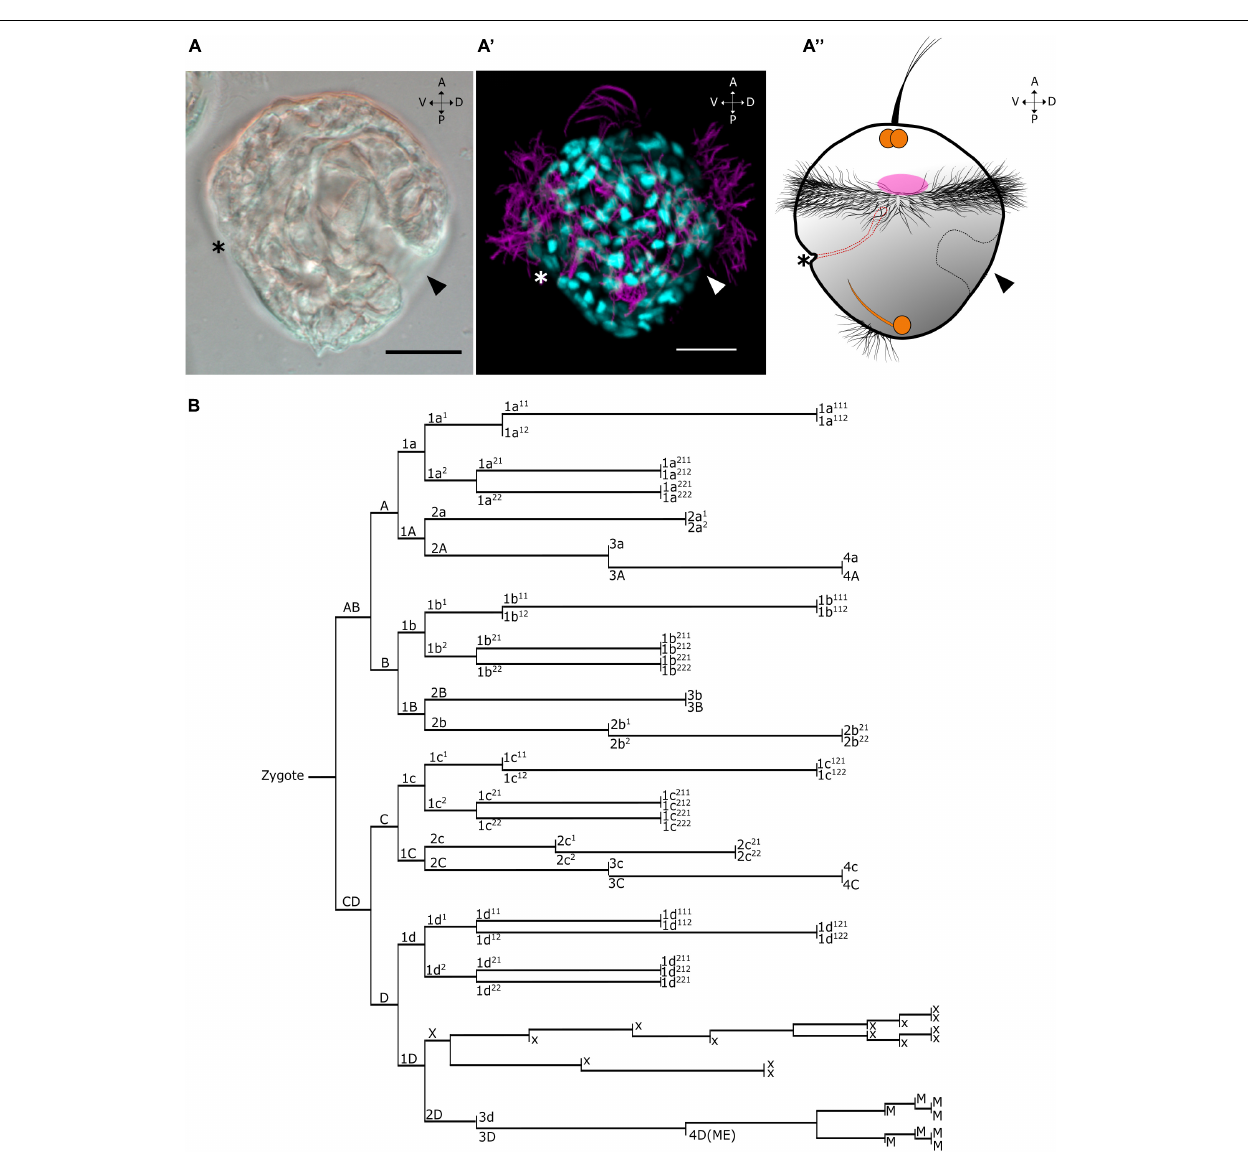
FIGURE 1 | Single-cell transcriptomics of Dreissena rostriformis larvae. Age of larvae is 13 hpf. (A–A”) Lateral view of differential interference contrast (left), alpha-acetylated tubulin/ DAPI immunostained trochophores (center), and scheme illustrating the overall morphology of the trochophore larva (right). Asterisk on the larvae indicates the mouth opening. Arrowhead points to the shell field on the right side. Orange marked areas denote the developing nervous system based on data from Pavlicek et al. (2018). Pink marked area denotes the developing muscular system. Dotted black lines highlight shell field cells. Dotted red lines highlight the developing digestive system. Anterior (A), posterior (P), ventral (V), and dorsal (D). Scale bars equal 20 µ m. (B) Cell lineage tree of Dreissena modified from Meisenheimer (1900) and Luetjens and Dorresteijn